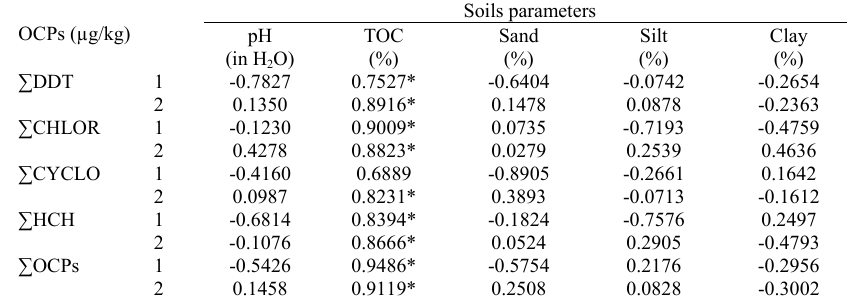
Soils parameters